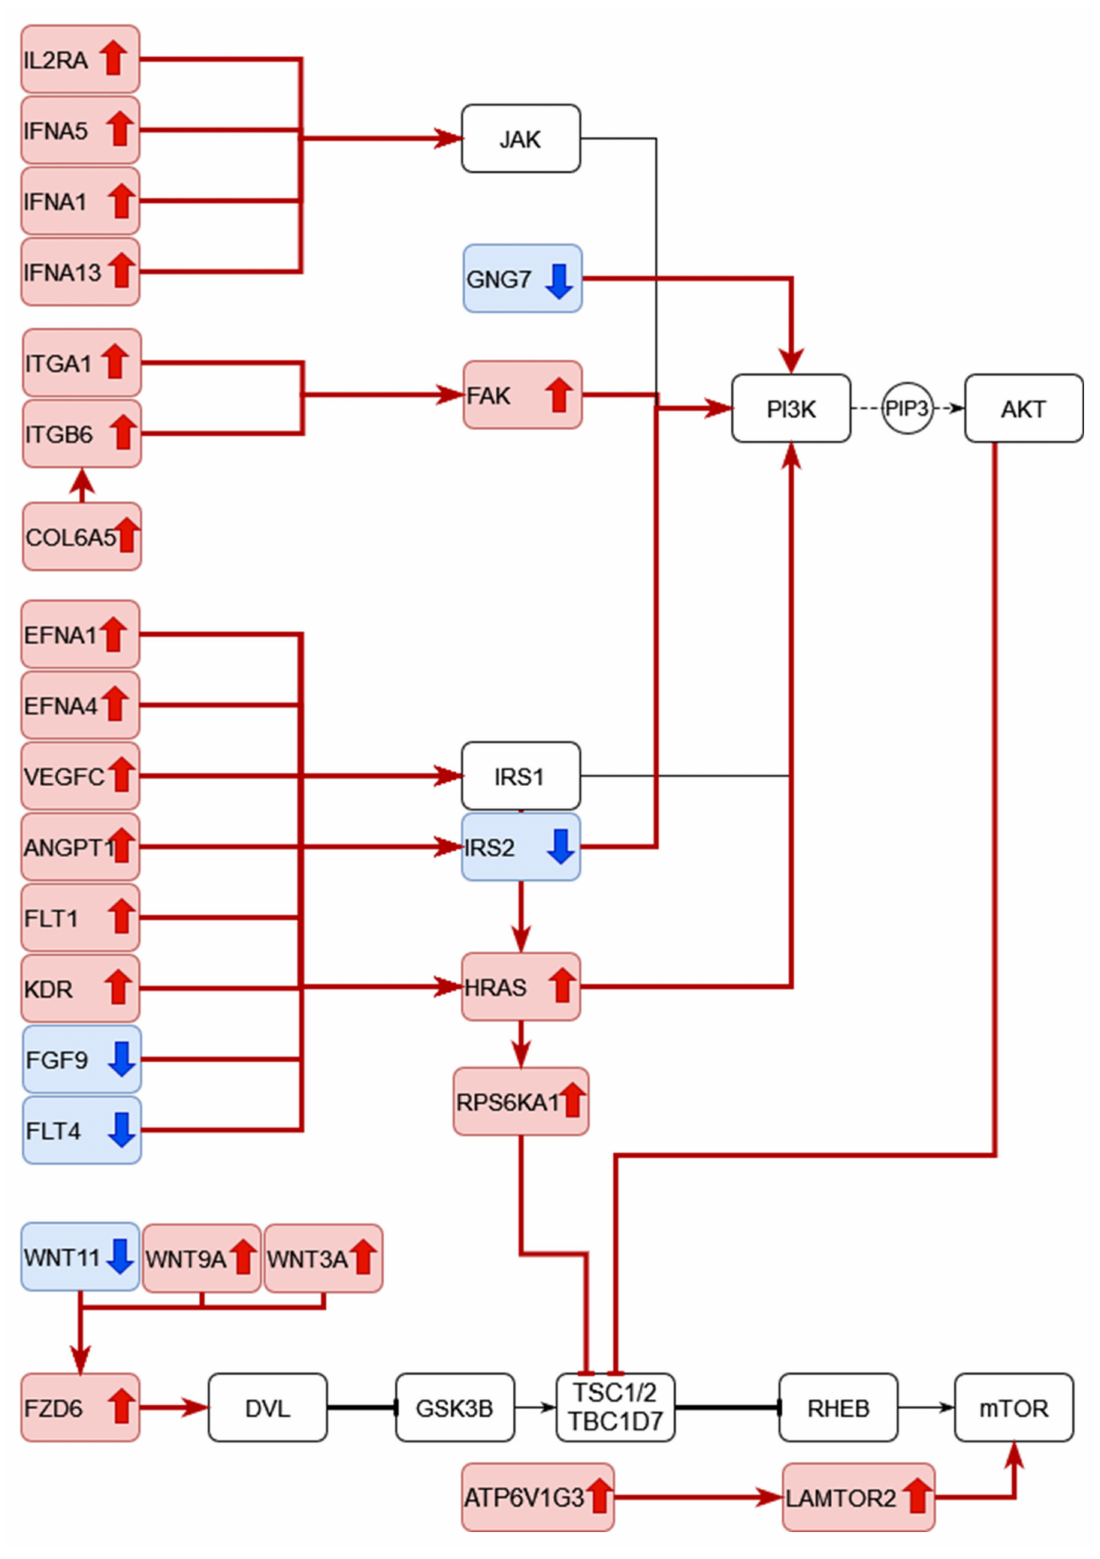
Figure 19. RA CD8 + Tem differentially expressed genes in the PI3K-AKT pathway and the mTOR pathway. Red up arrows indicate upregulation and blue down arrows indicate downregulation. Red connectors indicate the effect of the differentially regulated genes on their targets, whereas T shaped arrows indicate the inhibition and normal arrows indicate